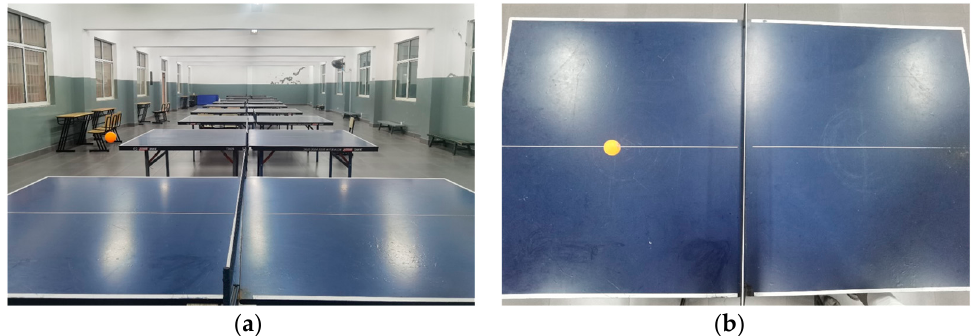
Figure 7. Example of a dataset: ( a ) sample data taken horizontally to the desktop and ( b ) sample data taken perpendicular to the desktop.